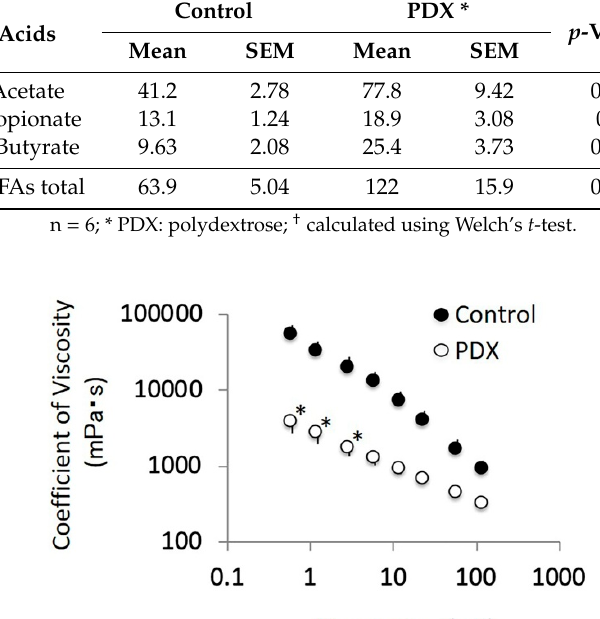
Table 3. Amounts of short-chain fatty acids (SCFAs) in cecal digesta, 4 weeks after feeding ( µ mol). Acids